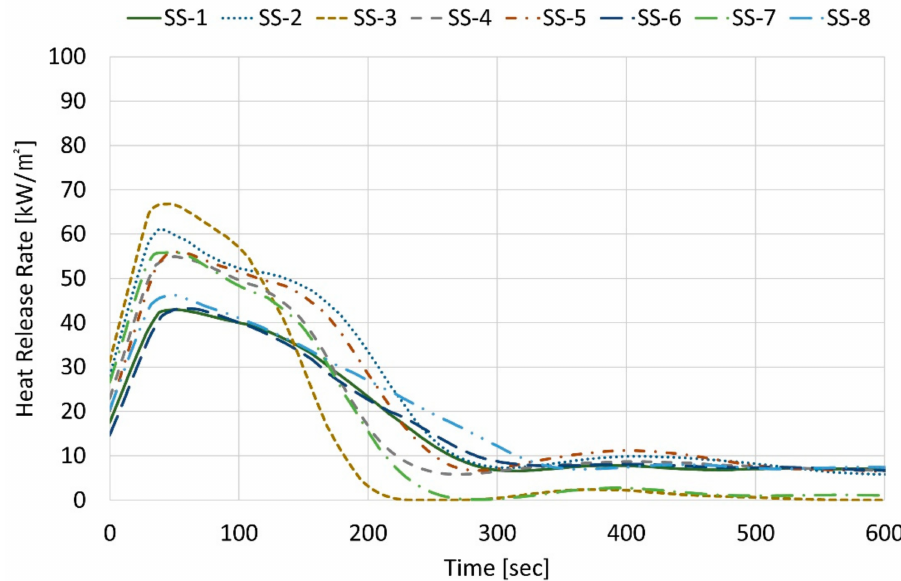
Figure 6. HRR of flame-retardant EPS samples according to the cone calorimeter method.